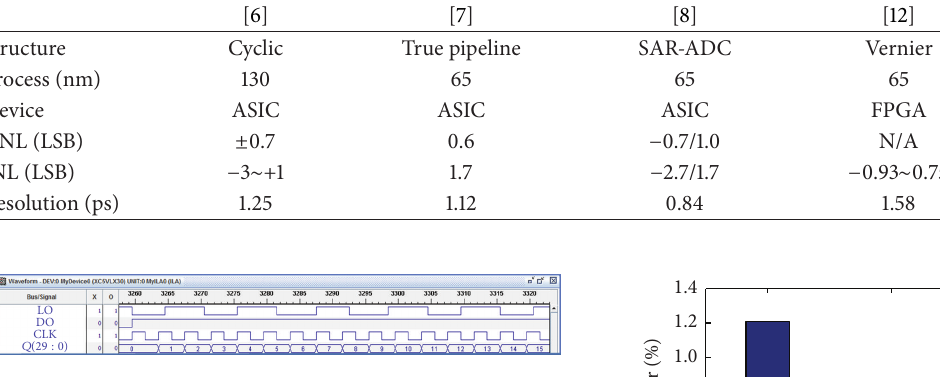
Figure 5: Measured timing diagram of the proposed TDC.